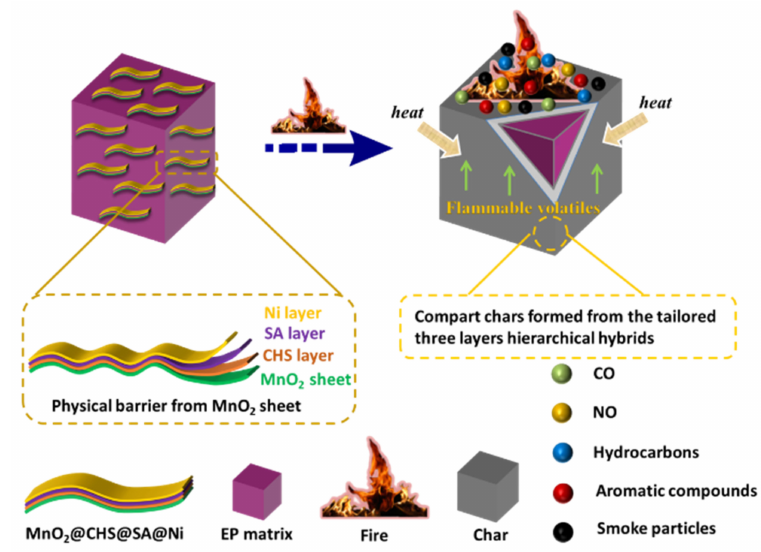
Figure 7. Potential flame-retardant mechanism of EP/MnO 2 @CHS@SA@Ni